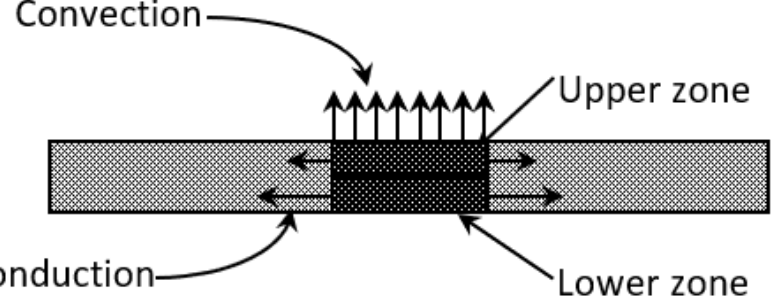
Figure 5. Heat exchanges between the weld material and the external environment.